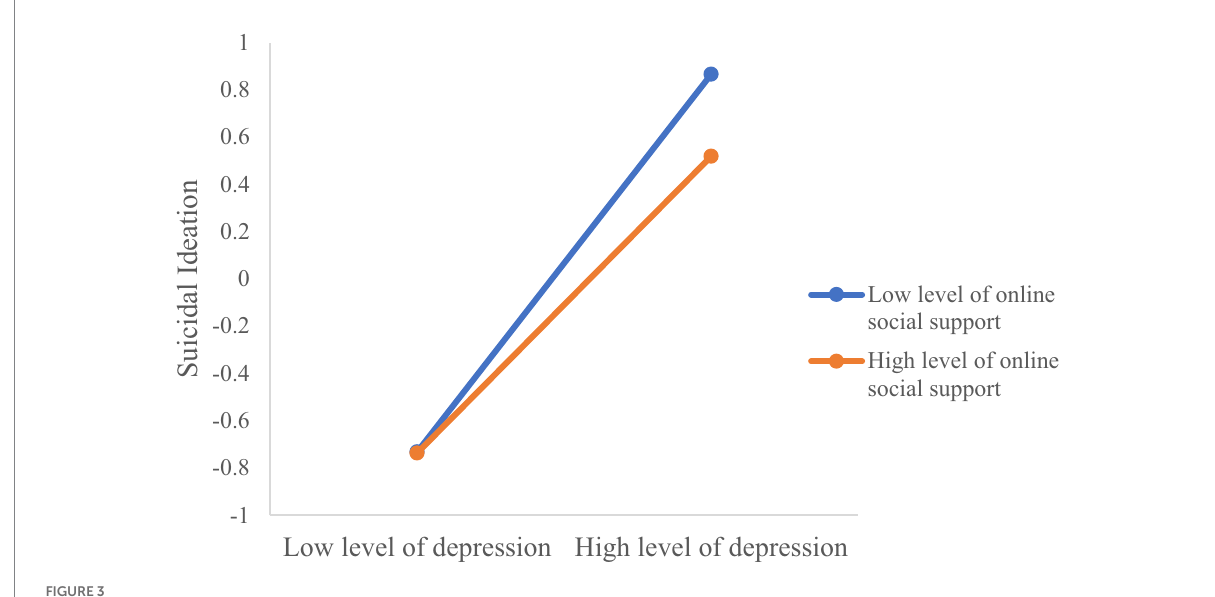
FIGURE 3 Simple slope test results for online social support moderating the association between depression and suicidal ideation. High = 1 standard deviations above the mean; Low = 1 standard deviations below the mean.